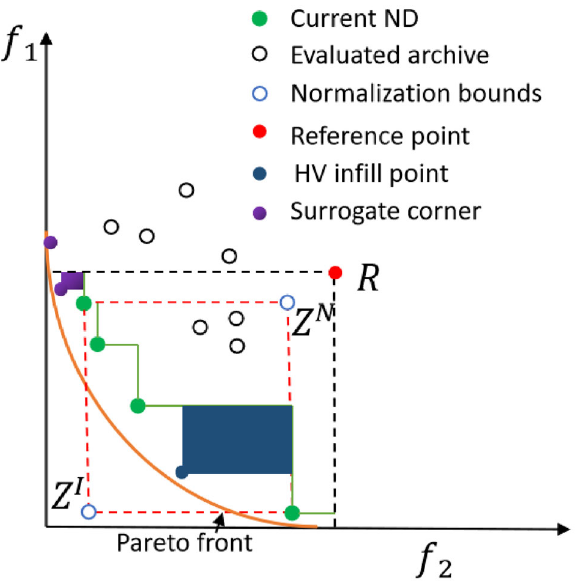
Fig. 5 Selection of corners based on their location relative to R Algorithm implementation